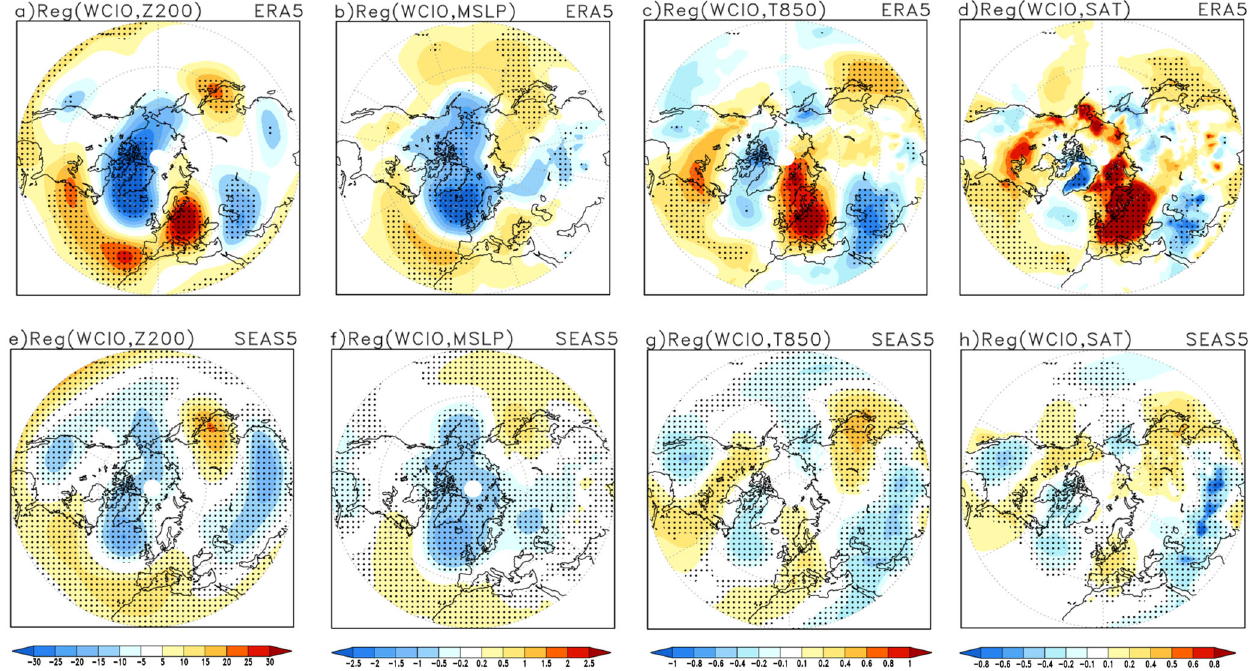
Fig. 4 Indian Ocean teleconnections to the North Atlantic European Region. a Observed Regression of the early winter (November – December; ND) WCIO precipitation anomalies index with the early winter (ND) 200-hPa geopotential height anomalies (Units; m) for the period 1981 – 2019; ( b ) same as of ( a ) but with Mean Sea Level Pressure (Units; hPa); ( c ) same as of ( a ) but for 850-hPa temperature anomalies (Units; K); ( d ) same as of ( a ) but for the Surface Air Temperature (Units; K) ( e – h ) Same as ( a – d ) but for ECMWF-SEAS5 dataset. Stippling denotes statistical signi fi cance at 95% con fi dence level. The observed (ECMWF-SEAS5) Correlation Coef fi cient (CC) between NAO index and WCIO is 0.44 (0.64), while with Niño3.4 is 0.42 (0.57), statistically signi fi cant at 95% con fi dence